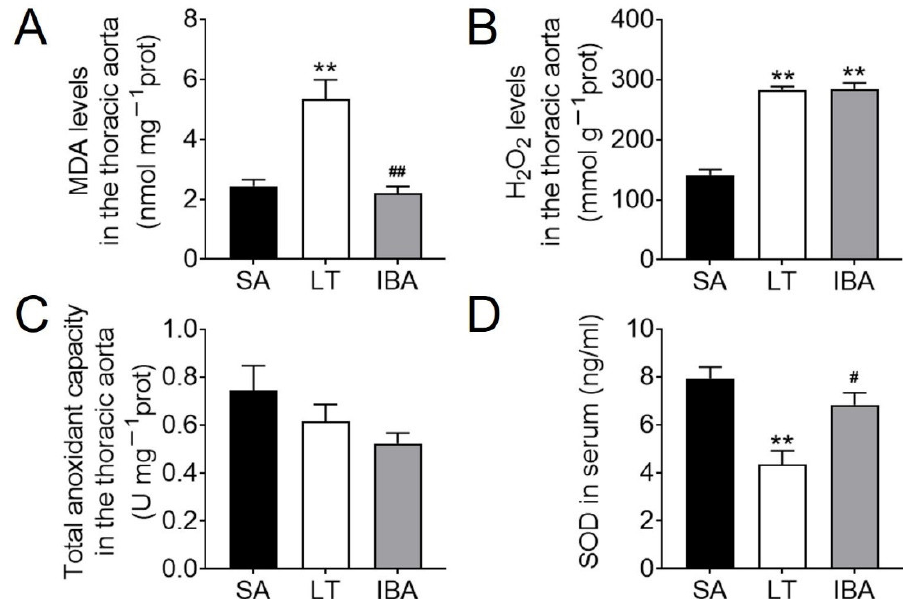
Figure 1. Levels of ROS and antioxidant capacity in the thoracic aorta and serum of ground squirrels. ( A ) MDA content in the thoracic aorta, n = 3. ( B ) H 2 O 2 content in the thoracic aorta, n = 5. ( C ) TAC in the thoracic aorta, n = 5. ( D ) SOD content in serum, n = 6. Samples are SA: summer active, LT: late torpor, and IBA: interbout arousal. Data are mean ± SEM. Significant differences between SA samples are denoted as follows: ** p < 0.01, whereas significant differences in IBA as compared with LT are denoted by # p < 0.05 or ## p < 0.01.